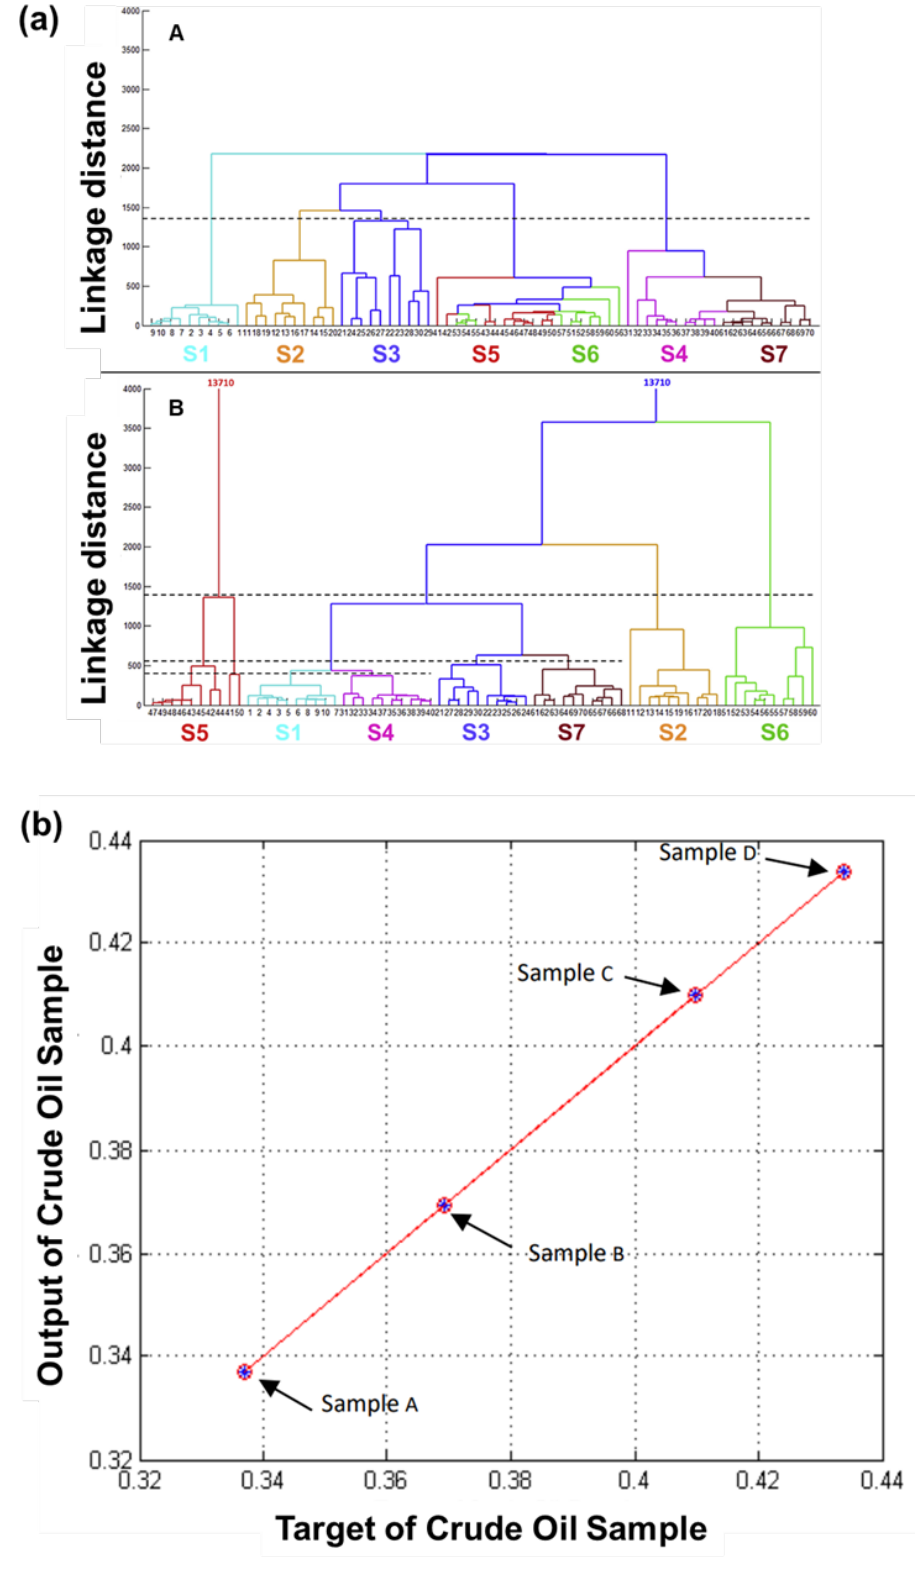
Figure 9. ( a ) Hierarchical cluster analysis (HCA) dendrogram obtained from air (A) and headspace (B) of the studied samples. Reprinted with permission [122]. ( b ) Regression plot obtained from waxy crude oil analysis. Reprinted with permission [24] .